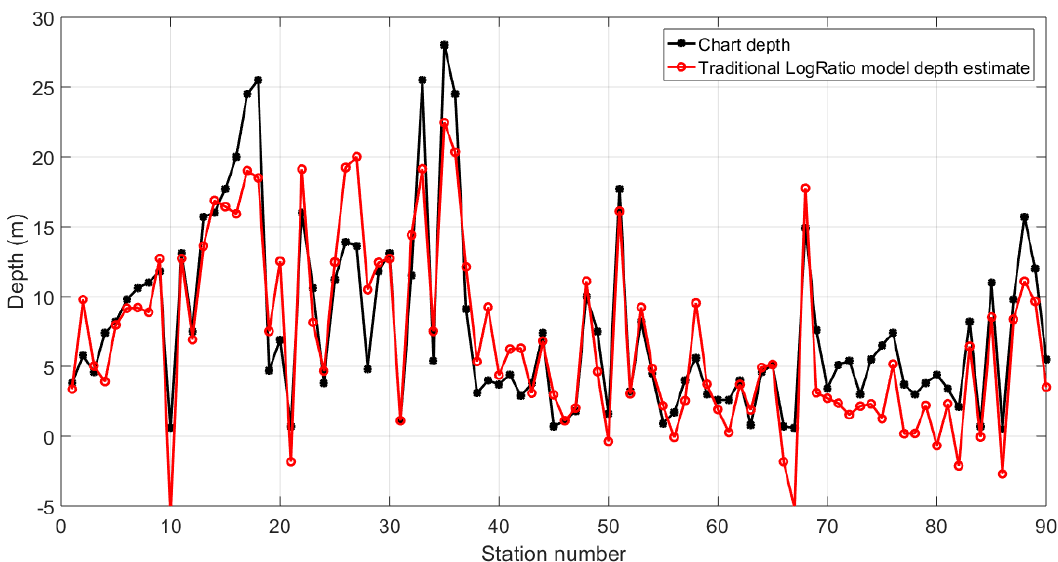
Figure 8. The modelled and validated model’s depth estimates versus the “truth” nautical chart depths values for the 90 collocated stations using the Stumpf log-ratio model.